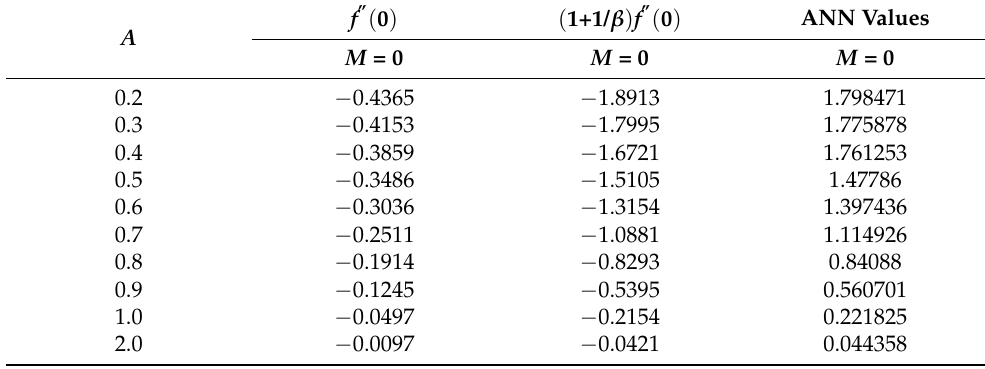
Table 3. Impact of the velocities ratio parameter on the SFC for the nonmagnetic flow field.